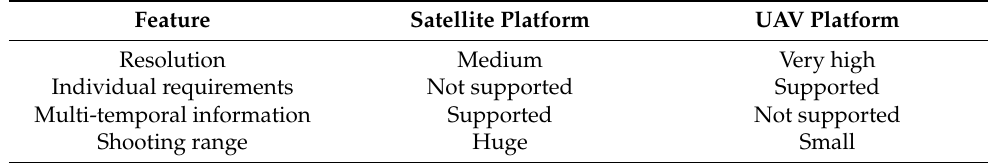
Table 12. Features of satellite and UAV platforms. Feature Satellite Platform UAV Platform Resolution Medium Very high Individual requirements Not supported